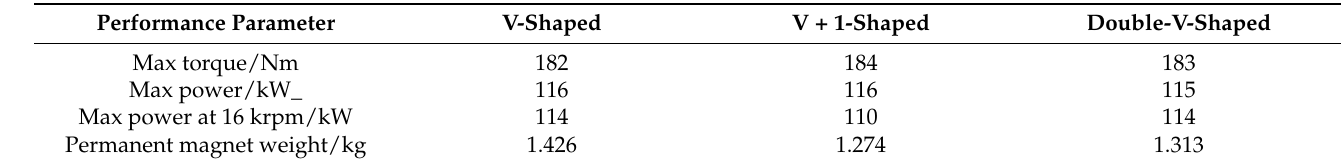
Table 6. Summary of different performance